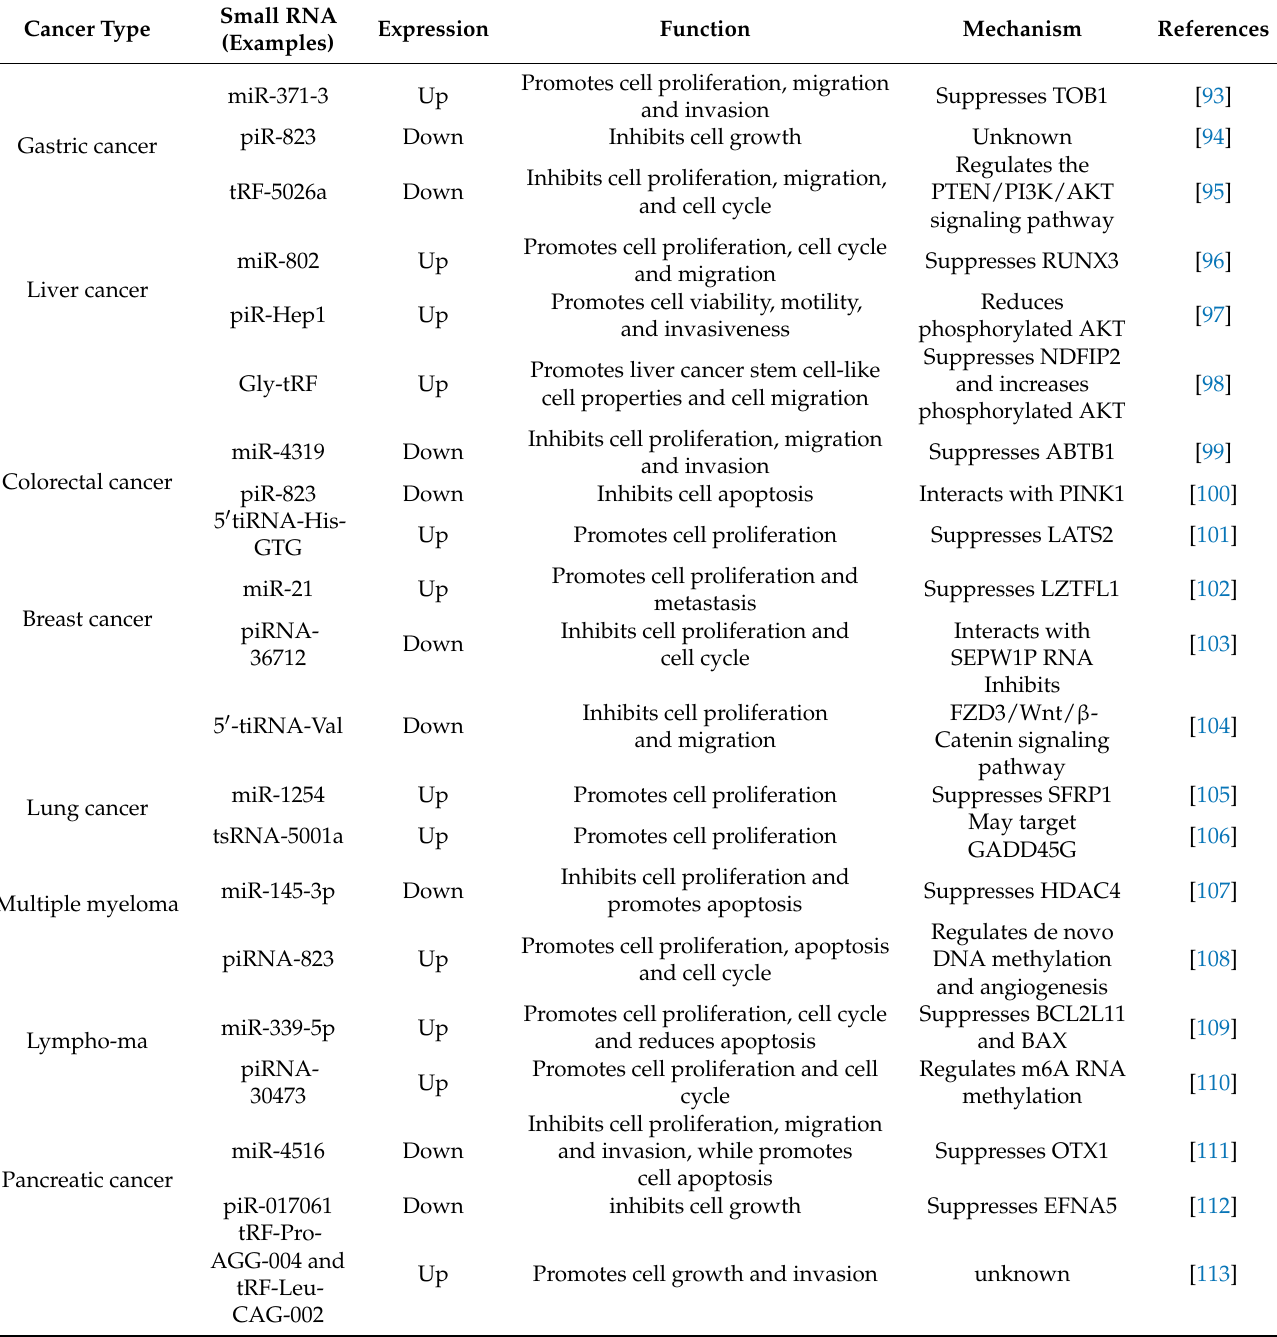
Table 1. Functions of small non-coding RNAs related to human